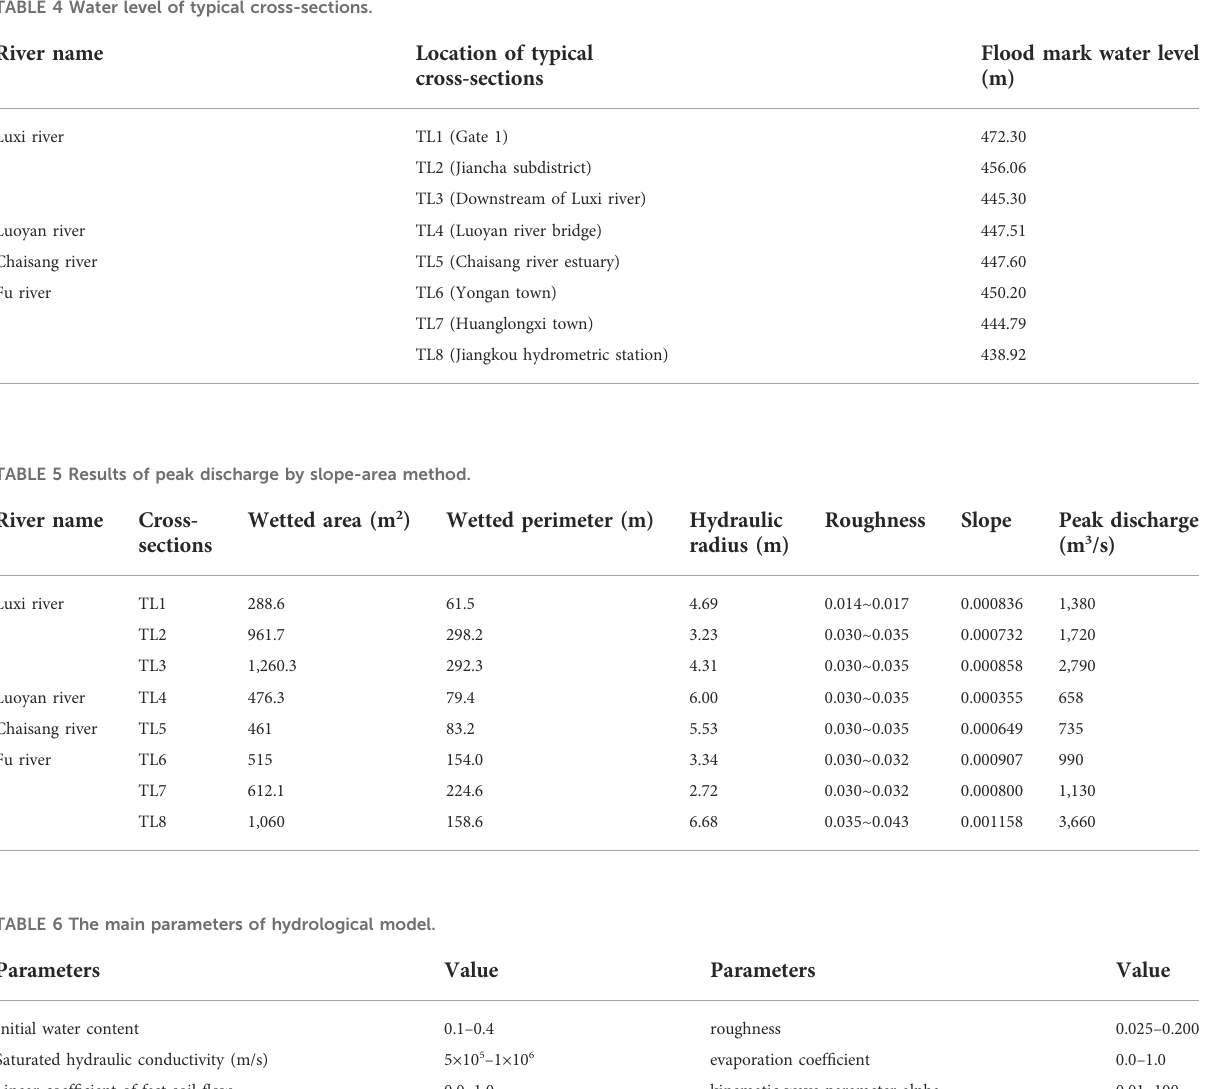
TABLE 4 Water level of typical cross-sections.